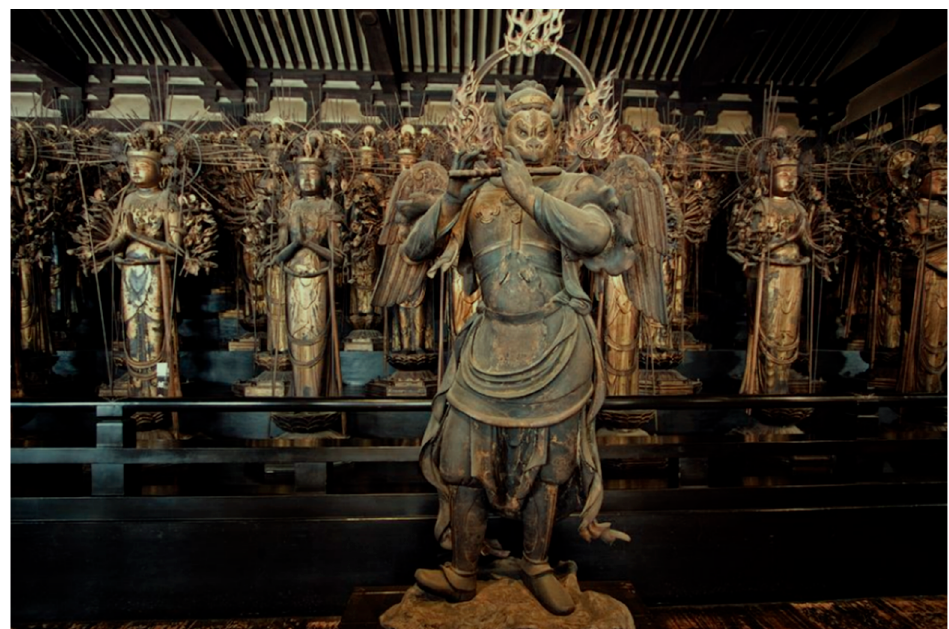
Figure 6. Sanju: the sculpture of Garuda 迦 楼 罗 on the Sando Temple. According to the iconography of this temple, Garuda is playing the flute, which may be fixed. It could be a stage of meditation on sound (this meditation practice originated in India and was taken up by Buddhism) (Esipova 2018, p. 26) .